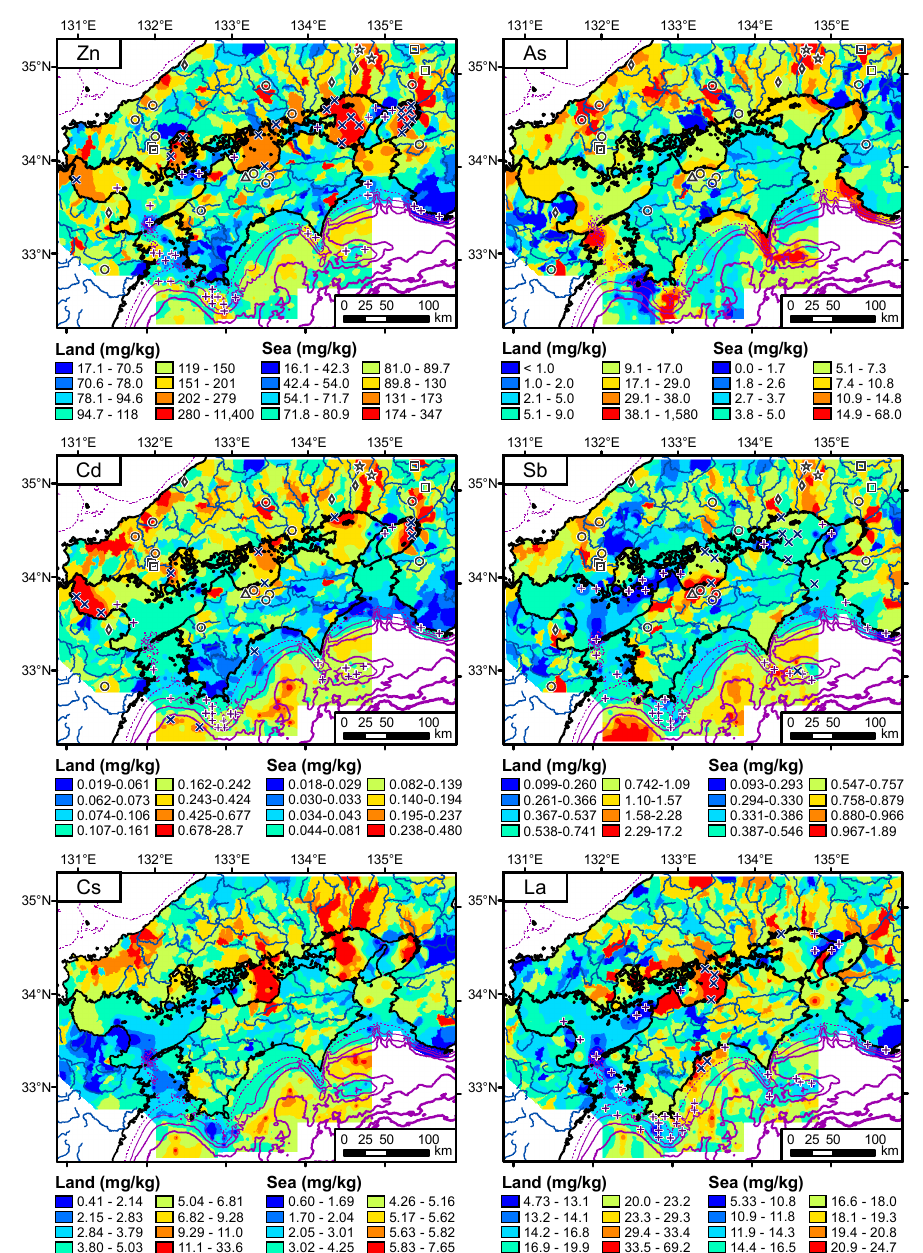
Figure 4. Spatial distributions of elemental concentrations in terrestrial and marine areas. The data are presented in wt % oxide (Al 2 O 3 , CaO, K 2 O, and T-Fe 2 O 3 ) and mg/kg element (Cr, Cu, Zn, As, Cd, Sb, Cs and La). Stars, circles, diamonds, squares and triangular symbols indicate major metalliferous deposits (as in Figure 1b). Cross and plus symbols indicate outliers obtained using Mahalanobis’ generalized distances (details in text in Section 5.5.1).